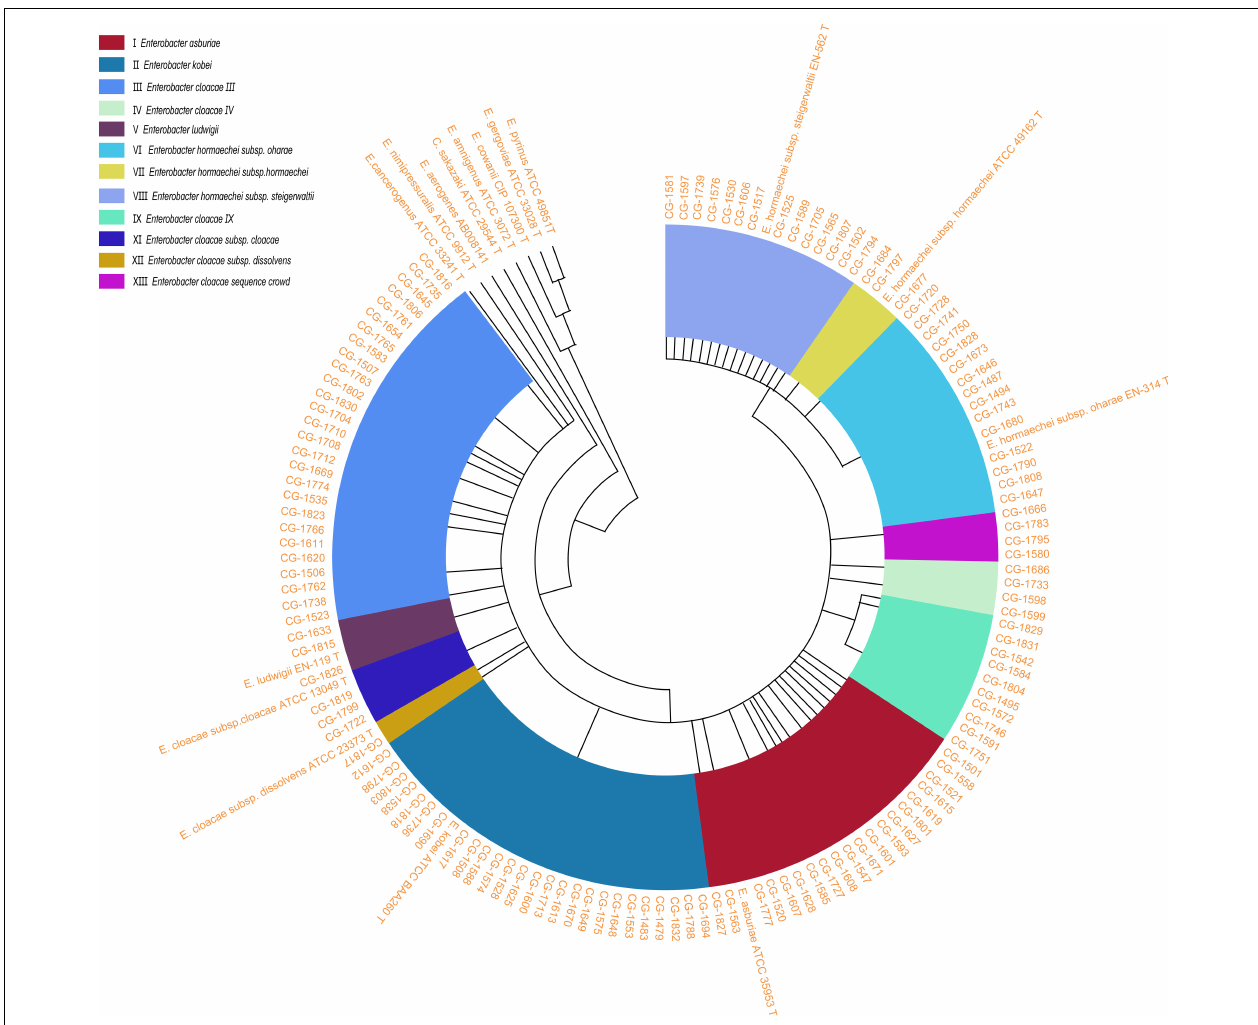
FIGURE 1 | An unrooted circle neighbor-joining tree with proportional branch length resulting from analysis of the hsp60 gene sequences of 130 clinical strains and previously reported sequences (Hoffmann and Roggenkamp, 2003; Hoffmann et al., 2005a,b; Iversen et al., 2008). The previously described strains correspond to sequences with GenBank accession numbers: E. asburiae ATCC 35853 T (AJ417141), E. kobei ATCC BAA260 T (AJ567899), E. cloacae subsp. dissolvens ATCC 23373 T (AJ417143), E. cloacae subsp. cloacae ATCC 13049 T (AJ417142), E. hormaechei subsp. steigerwaltii EN-562 T (AJ543908), E. hormaechei subsp. oharae EN-314 T (AJ543782), E. nimipressuralis ATCC 9912 T (AJ567900), E. hormaechei subsp. hormaechei ATCC 49162 T (AJ417108), E. ludwigii EN-119 T (AJ417114), E. cancerogenus ATCC 33241 T (AJ567895), E. amnigenus ATCC 3072 T (AJ567894), C. sakazaki ATCC 29544 T (AJ567902), E. cowanii ATCC 107300 T (AJ567896), E. pyrinus ATCC 49851 T (AJ567901), E. gergoviae ATCC 33028 T (AJ567897), and E. aerogenes AB008141 (AB008141). Genetic clusters are numbered according to the previous descriptions (Hoffmann and Roggenkamp, 2003). E. , Enterobacter .